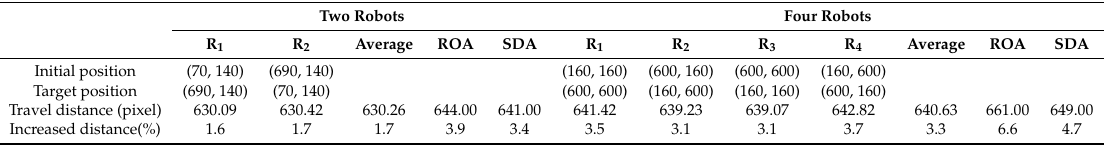
Table 4. Multi-robot navigation performance comparison (two and four robot cases). ROA: reciprocal orientation algorithm; SDA: shortest distance algorithm.